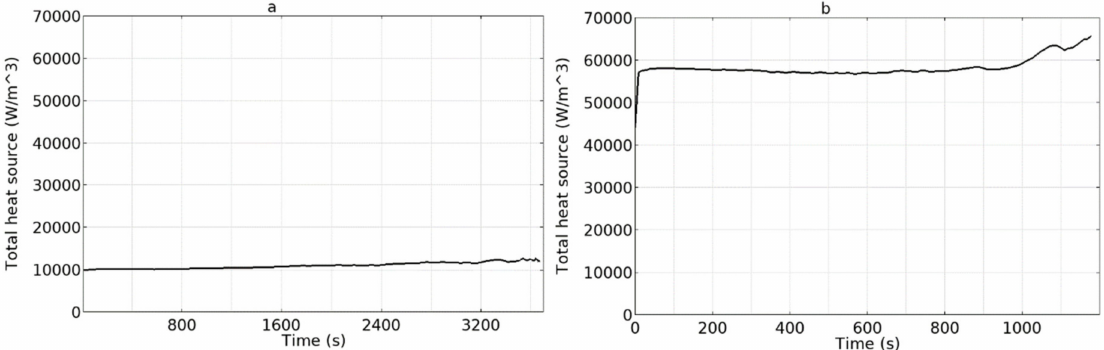
Figure 4. Total heat generation at ( a ) 1C and ( b ) 3C